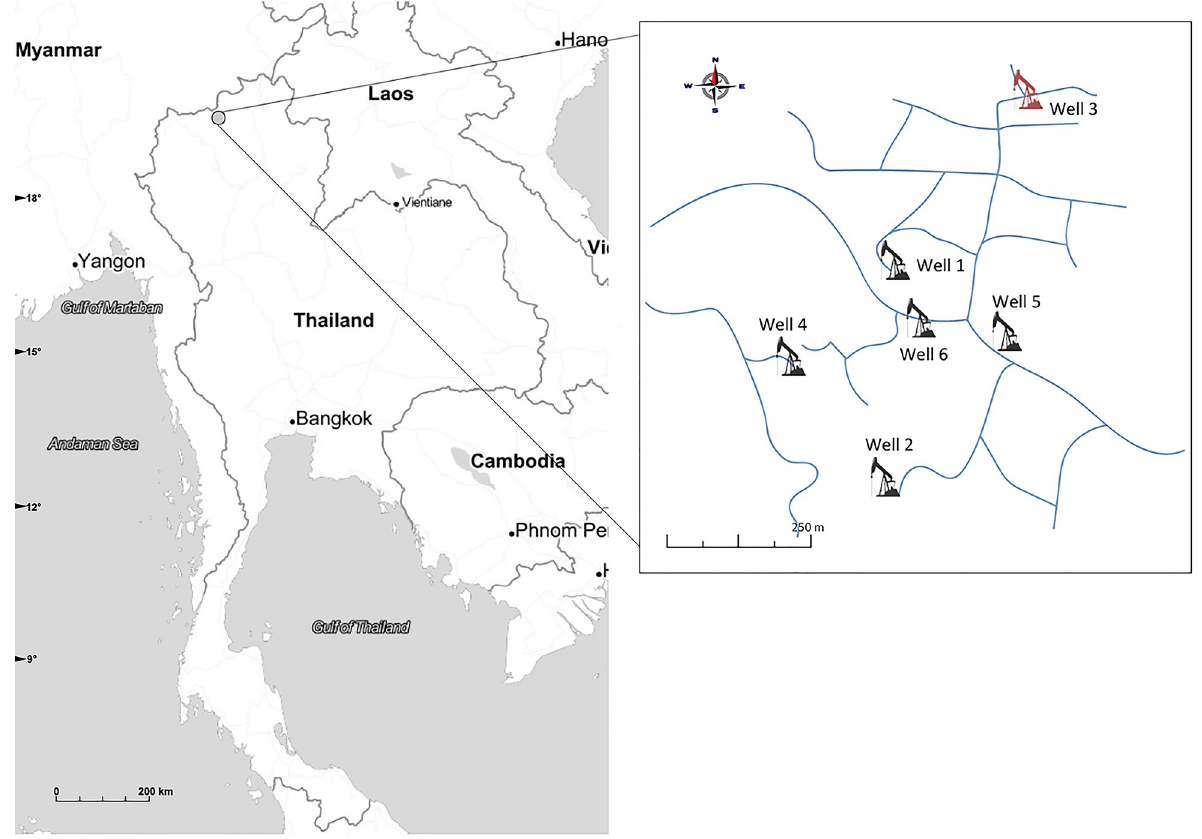
Fig 1. Location and distribution of six oil wells in Mae Soon reservoir, Fang oil field,